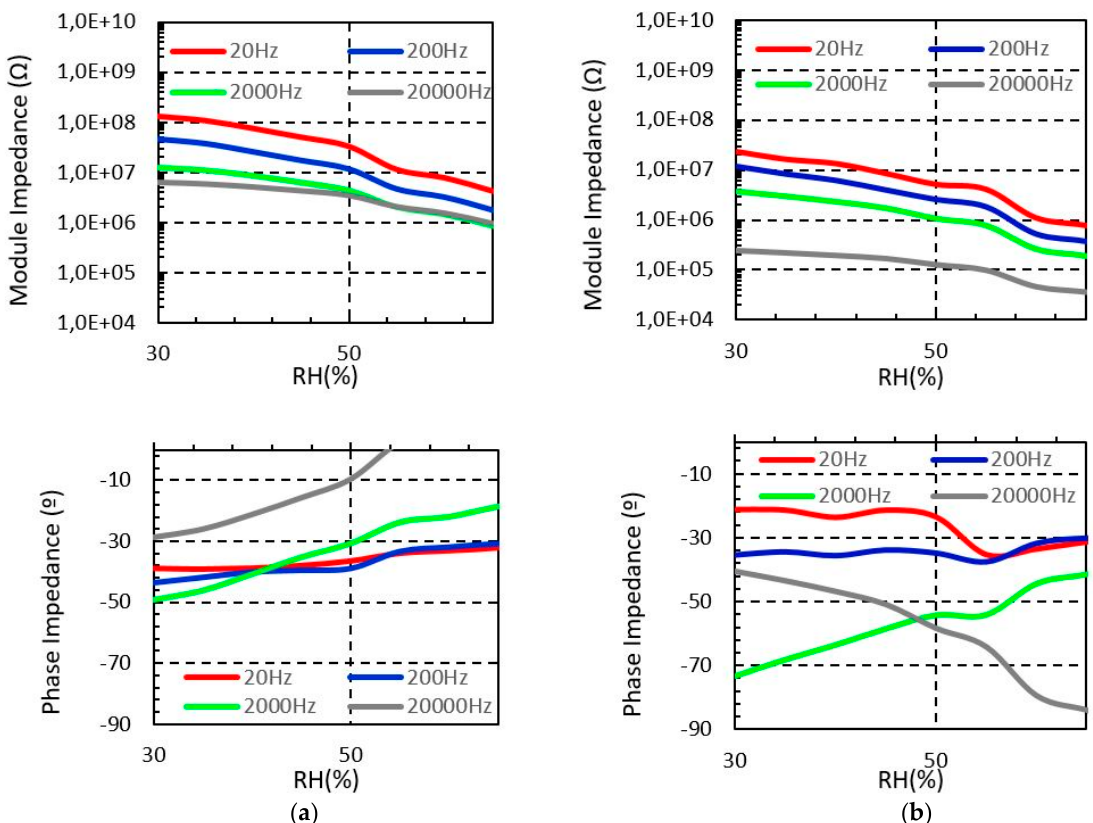
Figure 6. Measured Bekaert (CO-SS) sensors impedance from 30% to 65% RH at different frequencies (T = 20 °C). ( a ) Short sensor impedance ( b ) Long sensor impedance.